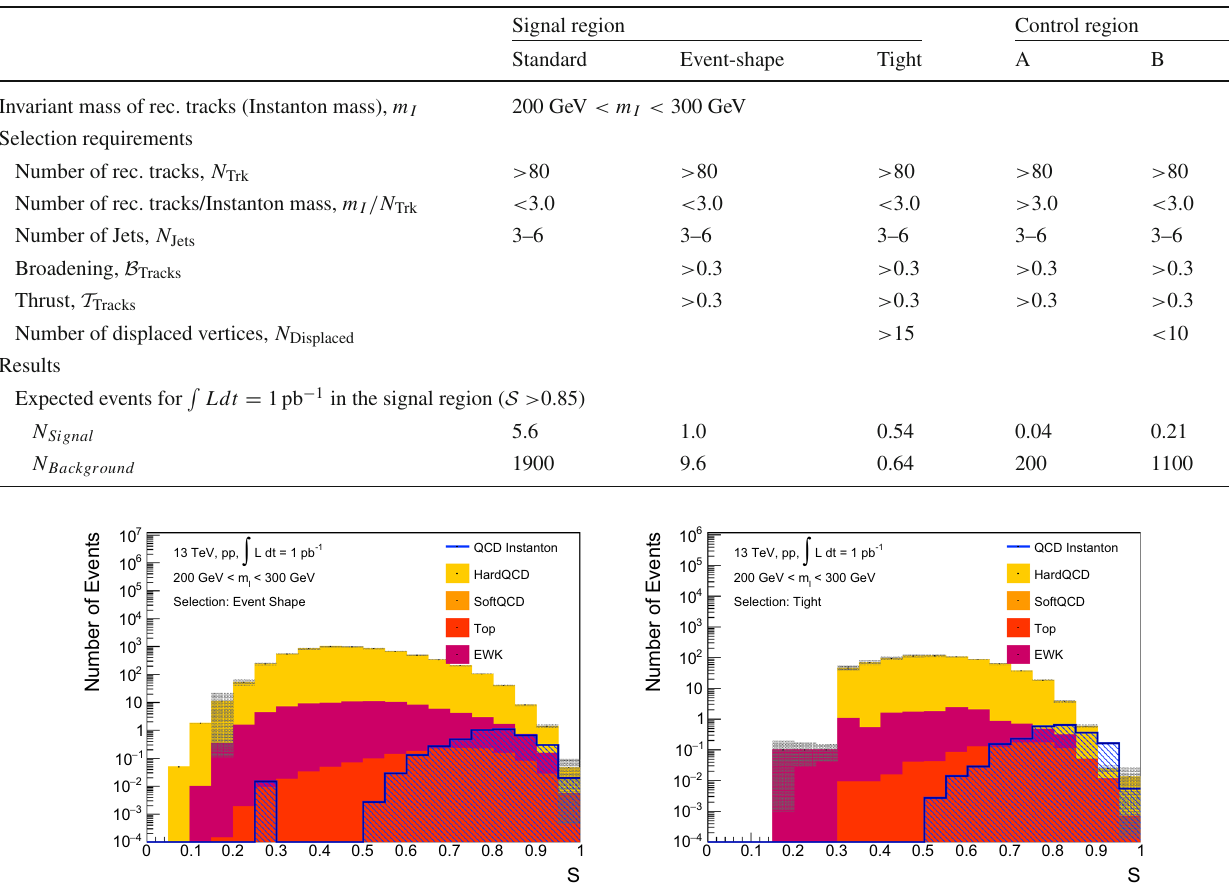
Fig. 15 Predicted distributions of S for an integrated luminosity of L = (right). The invariant mass of all reconstructed tracks is required to be between 200 and 300 GeV (medium mass regime)